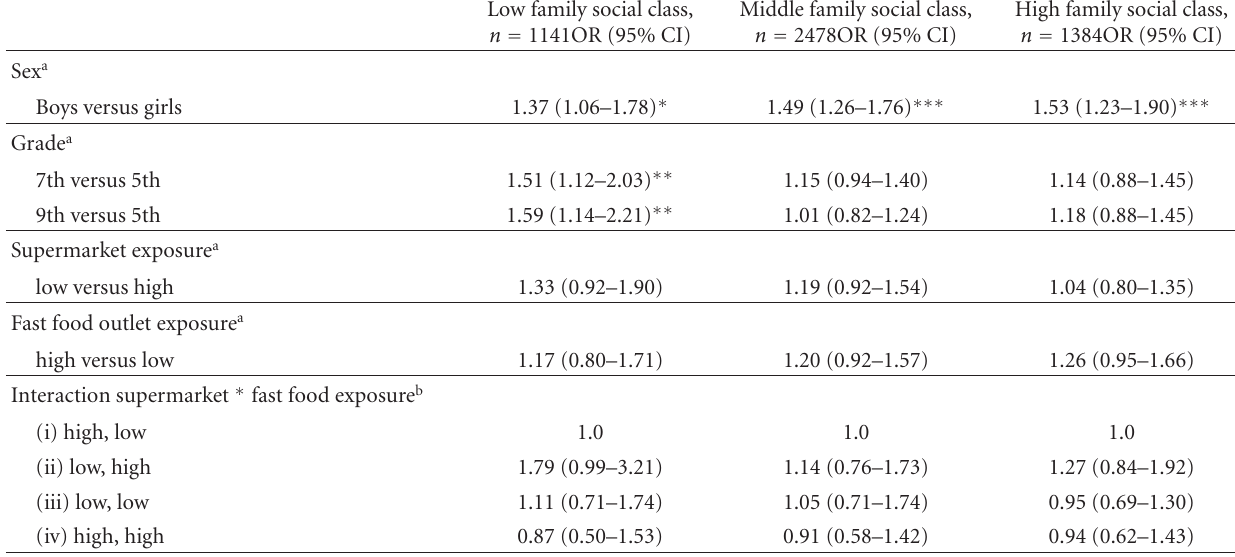
Table 3: Adjusted odds ratios (95% CI) for infrequent vegetable consumption, separate analyses for students in low, middle, and high family social